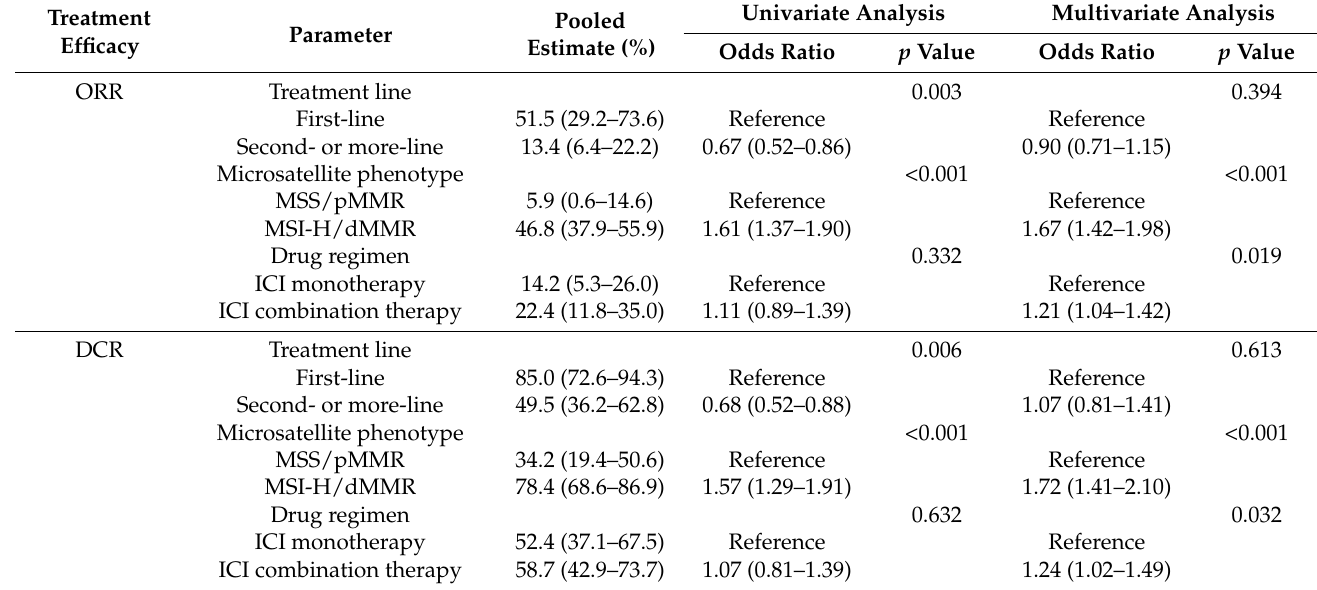
Table 3. Results of the univariate and multivariate meta-regression